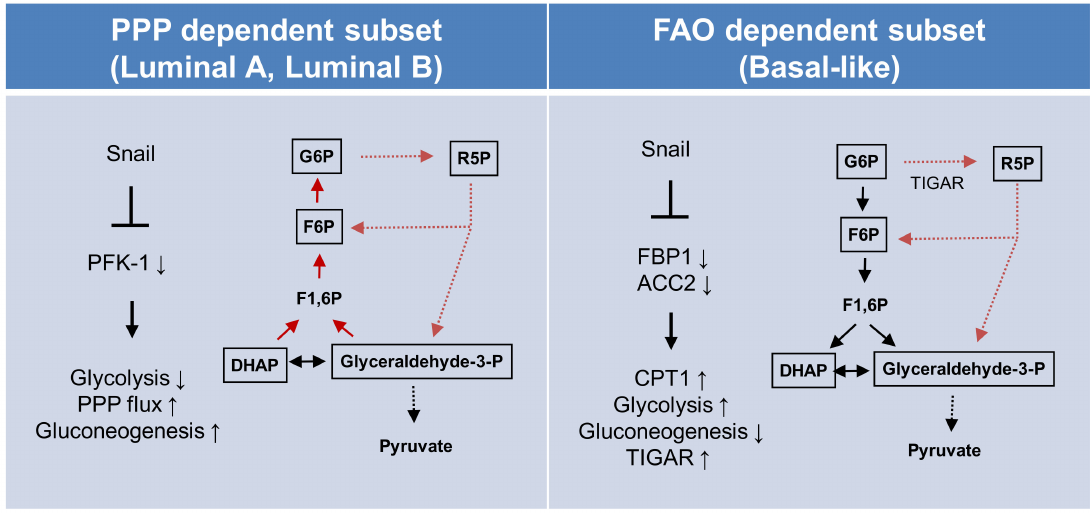
Figure 5. Proposed model of EMT-mediated catabolic metabolism in breast cancer subtypes. Proposed divergent metabolic models of PPP-dependent luminal subtype (left) and a FAO-dependent basal-like subtype (right) of breast cancer indicate Snail involvement in catabolic metabolism and cancer cell survival. Abbreviations: PPP, pentose phosphate pathway; FAO, fatty acid oxidation; ACC2, acetyl-CoA carboxylase 2; CPT1, carnitine palmitoyltransferase I; G6P, glucose 6-phosphate; R5P, ribose-5-phosphate; F6P,fructose 6-phosphate; TIGAR, TP53-inducedglycolysis andapoptosis regulator; PFK-1 phosphofructokinase-1; FBP1, fructose 1,6-bisphosphatase 1; F1,6BP, fructose 1,6-bisphosphate; DHAP, dihydroxyacetone